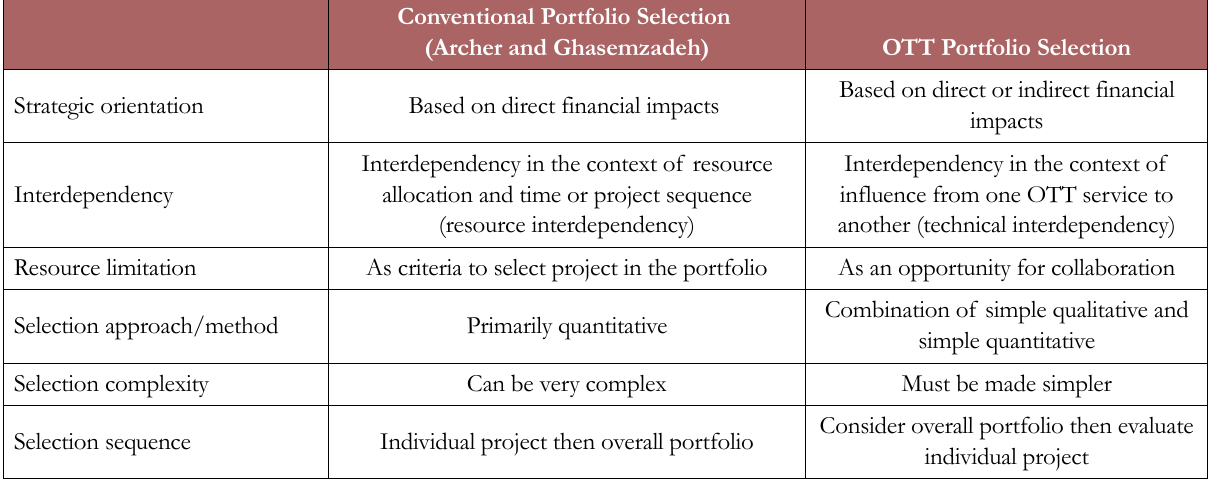
Table 2. Comparison between Conventional Portfolio Selection and OTT Portfolio